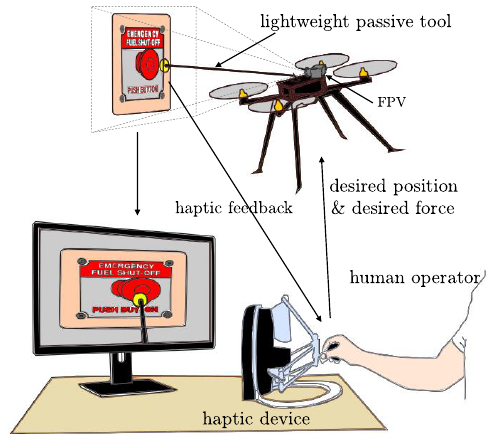
Figure 1. A conceptual example of aerial tele-manipulation with a passive tool: an aerial robot equipped with a lightweight passive tool tasked to press an emergency shut down push button.